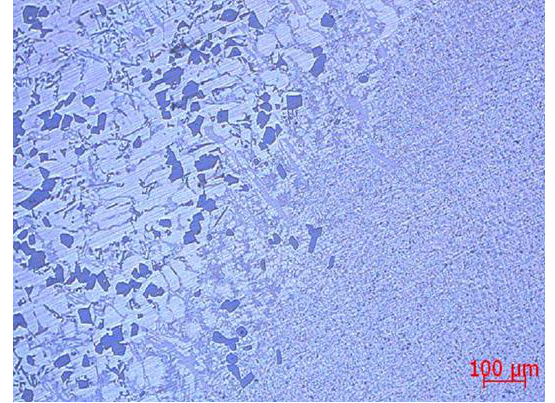
Fig. 10. DuralBowl remelting